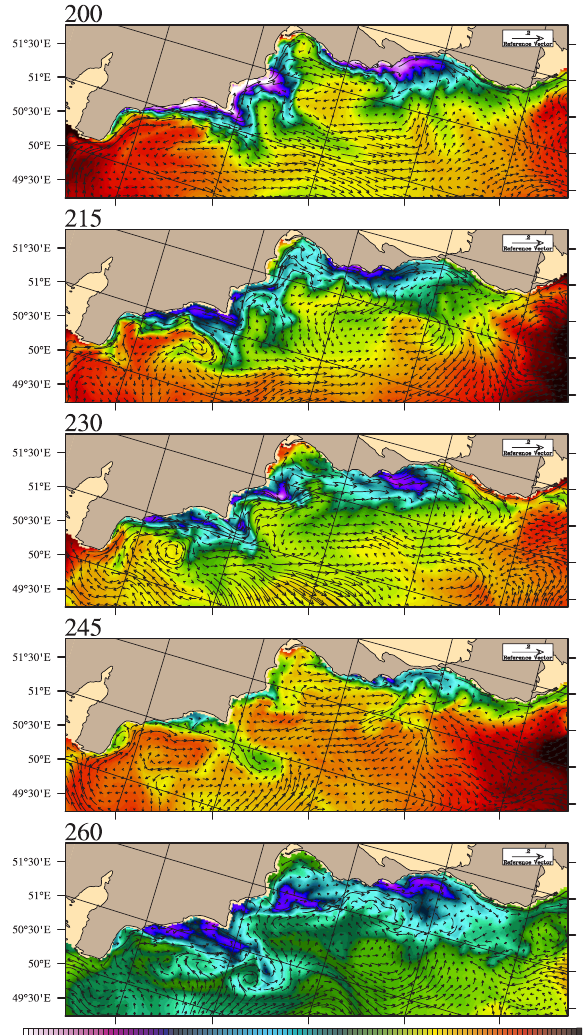
Figure 10. Snapshot of the model SST of the eighth model year along the eastern coast of the Sea. The model days are shown at the upper left side of the each